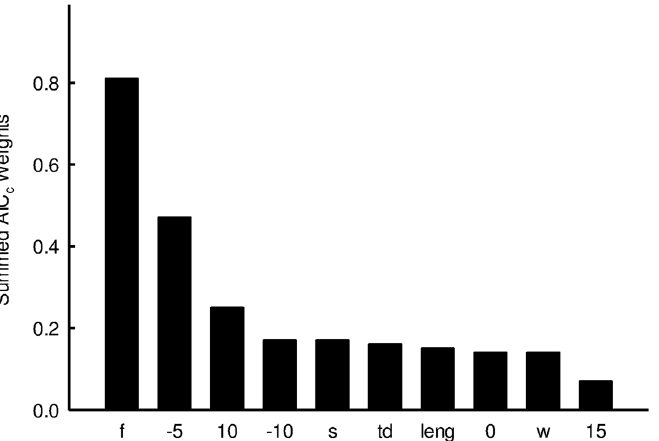
Fig 3. Summed Akaike weights for local microclimate and forage predictor variables. Summed Akaike weights indicating overall support for predictor variables (f = forage; -5 = number of days below -5°C; 10 = number of days above 10°C; -10 = number of days below -10°C; s = mean summer temperature; td = total degree days; leng = length of the growing season; 0 = days below 0°C; w = mean